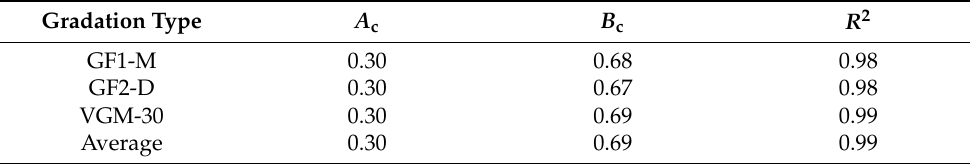
Table 7. Fitting regression coefficients of R cT / R c ∞ ~ T